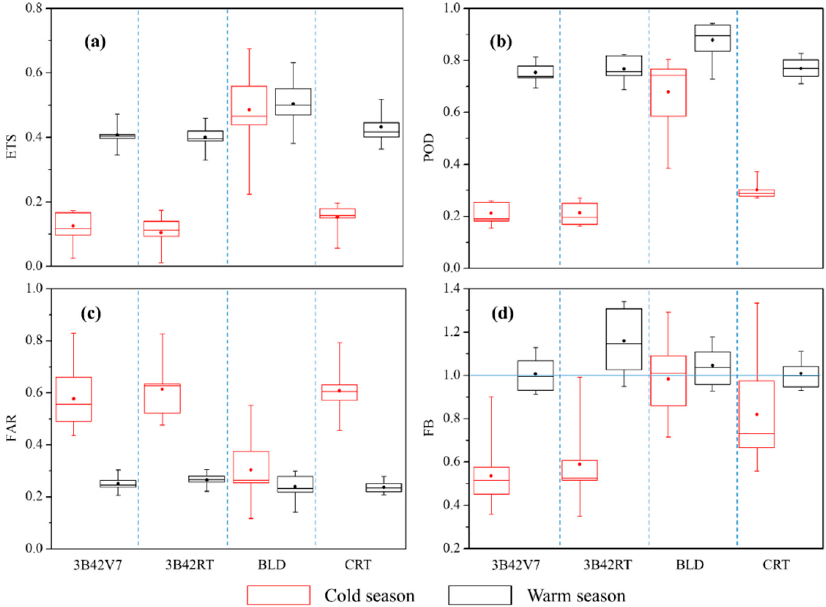
Figure 5. Box plots of grid based metrics in cold and warm seasons for different precipitation products at daily timescale from 2006–2013: ( a – d ) represents ETS, POD, FAR and FB, respectively.